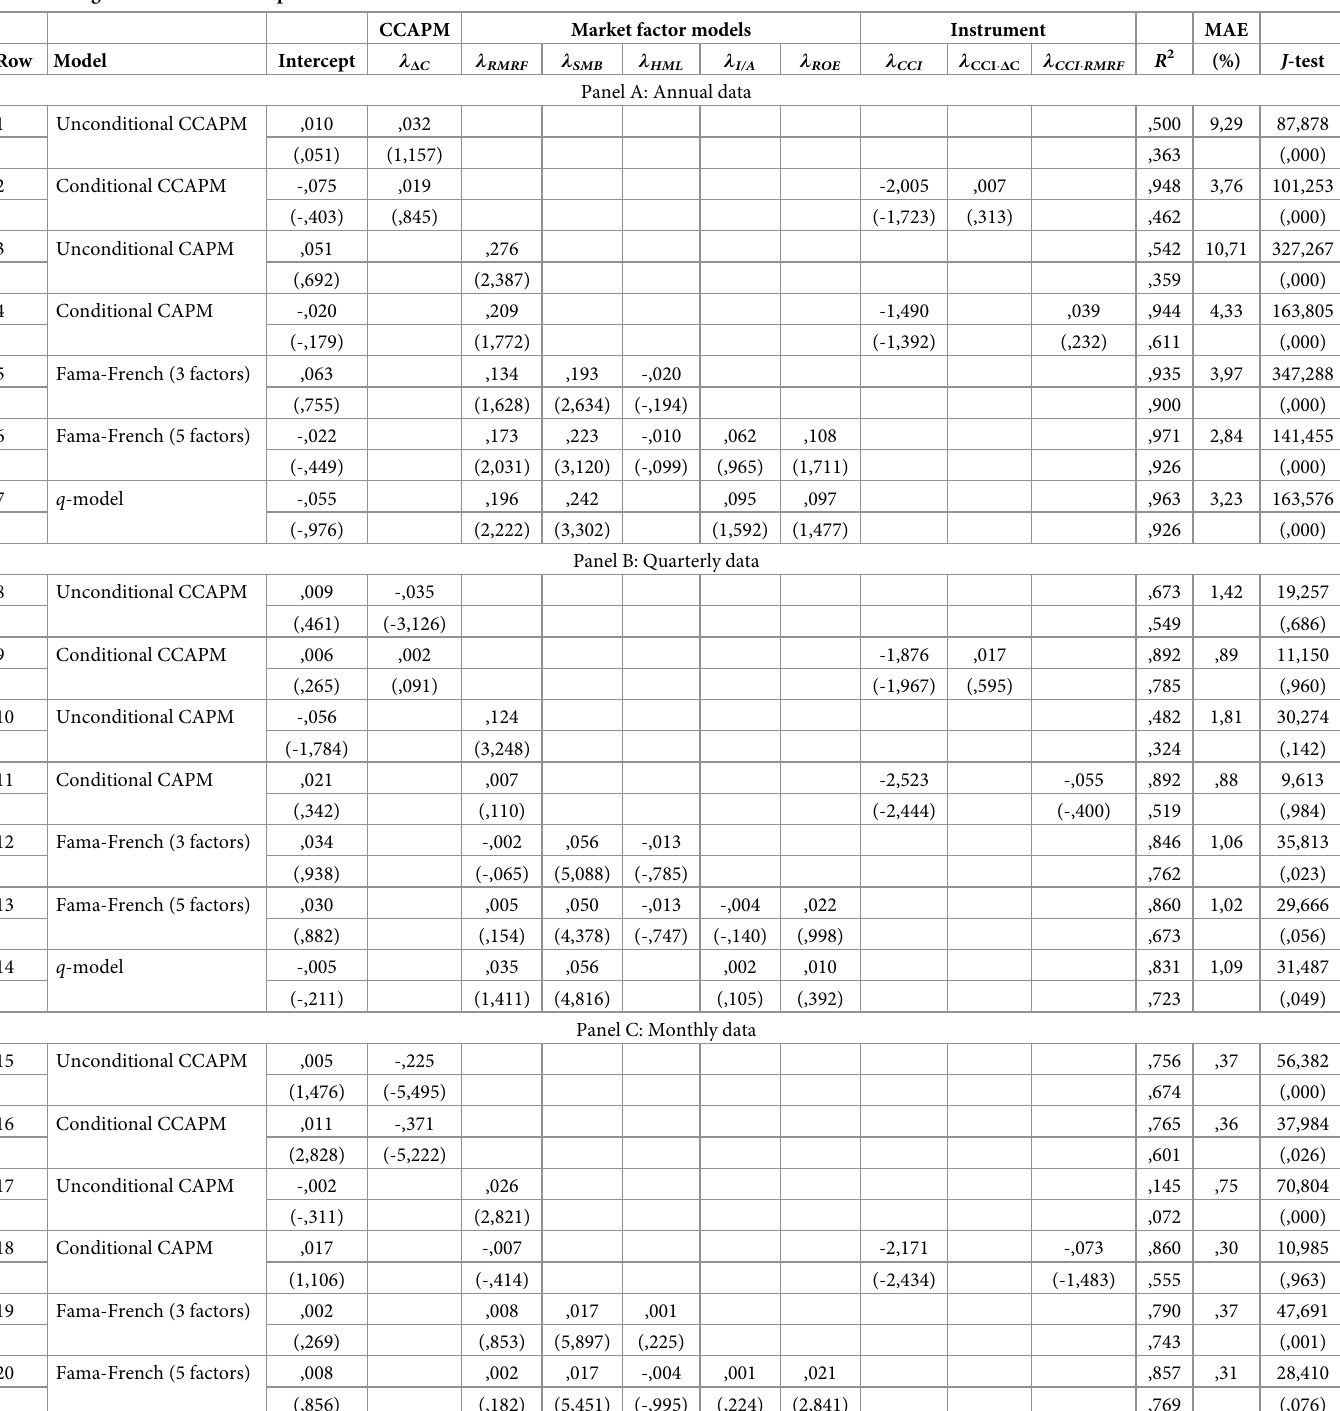
Table 4. Regression results for 25 portfolios